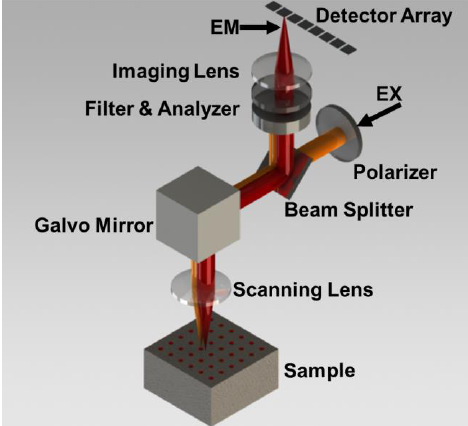
Figure 3. MFMT optical setup accepts the incoming light (EX) after a linear